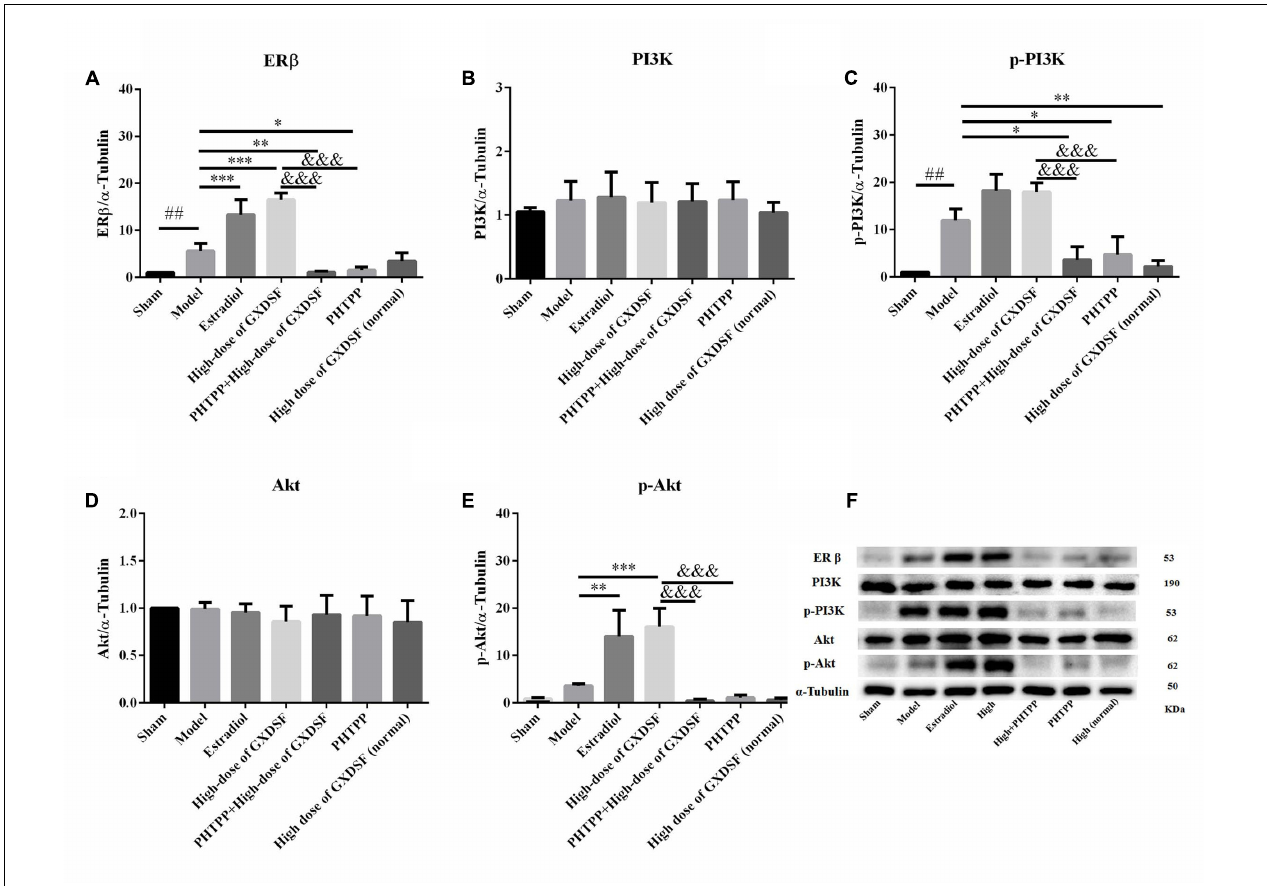
FIGURE 9 | Relative expression of ER β (A) , PI3K (B) , p-PI3K (C) , Akt (D) , p-Akt (E) and an internal reference ( α –tubulin) (F) in MIRI-LVR rats treated with high-dose of GXDSF treated group and PHTPP. Compared with the sham group: ## P < 0.01. Compared with the MIRI-LVR model group: ∗ P < 0.05, ∗∗ P < 0.01, ∗∗∗ P < 0.001. Compared with the high-dose of GXDSF treated group: &&& P < 0.001. The data are presented as the mean ± SD ( n = 6 in each